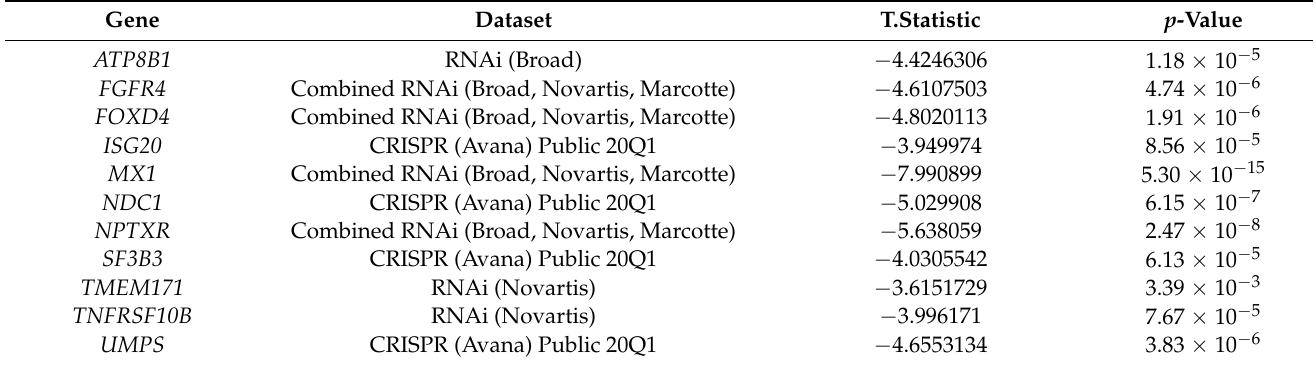
Table 4. DEMETER2 and CERES score comparison between MM cell lines and other cancer cell lines. DEMETER2 and CERES scores were calculated from CRISPR-Cas9 and RNAi-based viability assays, respectively.